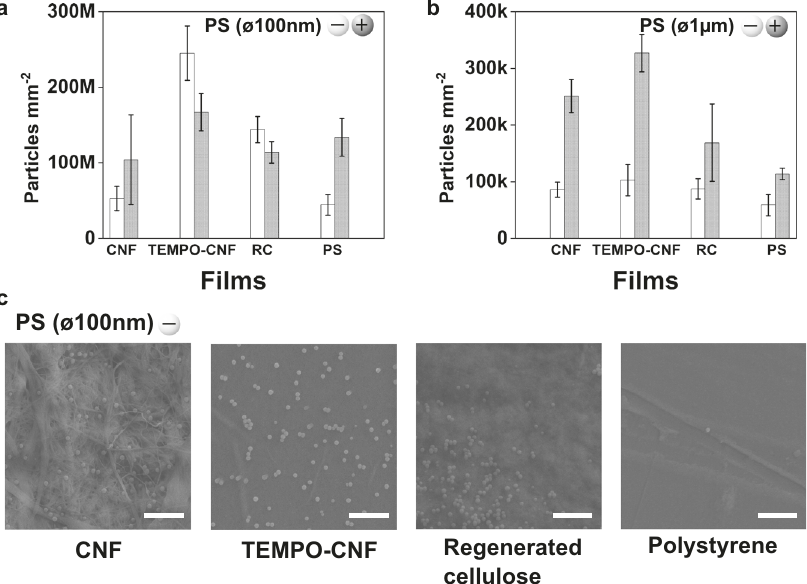
Fig. 2 Quantitative assessment of entrapped fl uorescent nano- and microplastic particles of different size and charge by self-standing fi lms. a Number of captured nanoplastic polystyrene (PS) particles PS(ø100 nm) and ( b ), microplastic particles PS(ø1 µ m) calculated based on the fl uorescence detection. White bars represent negatively charged plastic particles, and gray bars positively charged plastic particles. The full data for all captured particles are presented in Supplementary Table 2. Error bars in ( a ) and ( b ) indicate mean ± SD. c SEM images of the fi lms after being contacted with the anionic PS(ø100 nm) dispersion for 10 min. Scale bar in SEM images is 1 µ m. Source data are provided as a Source Data fi